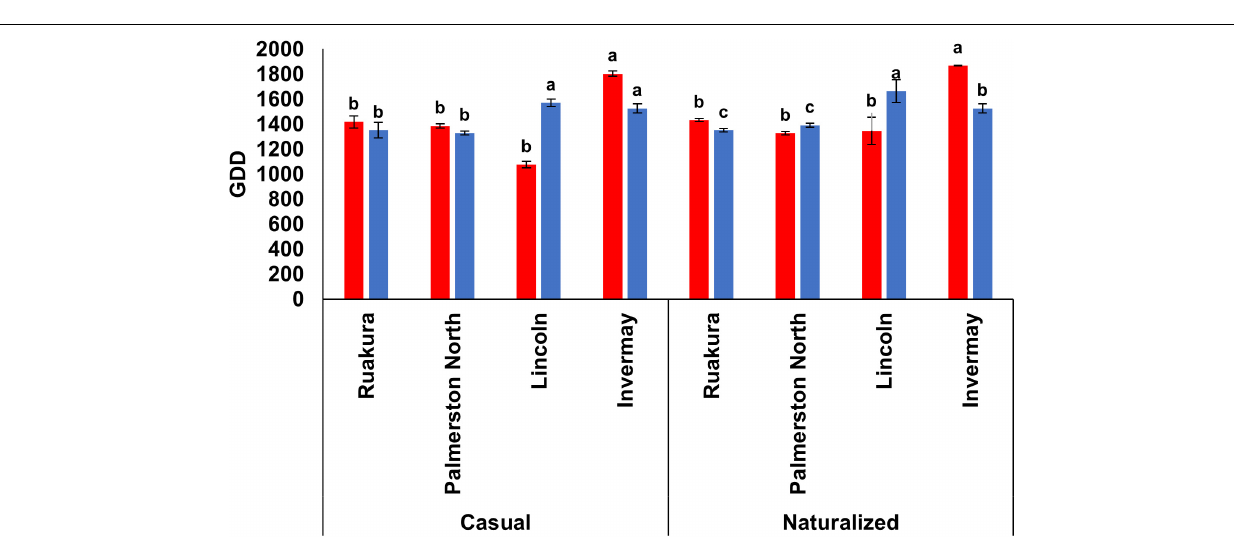
Frontiers in Plant Science |